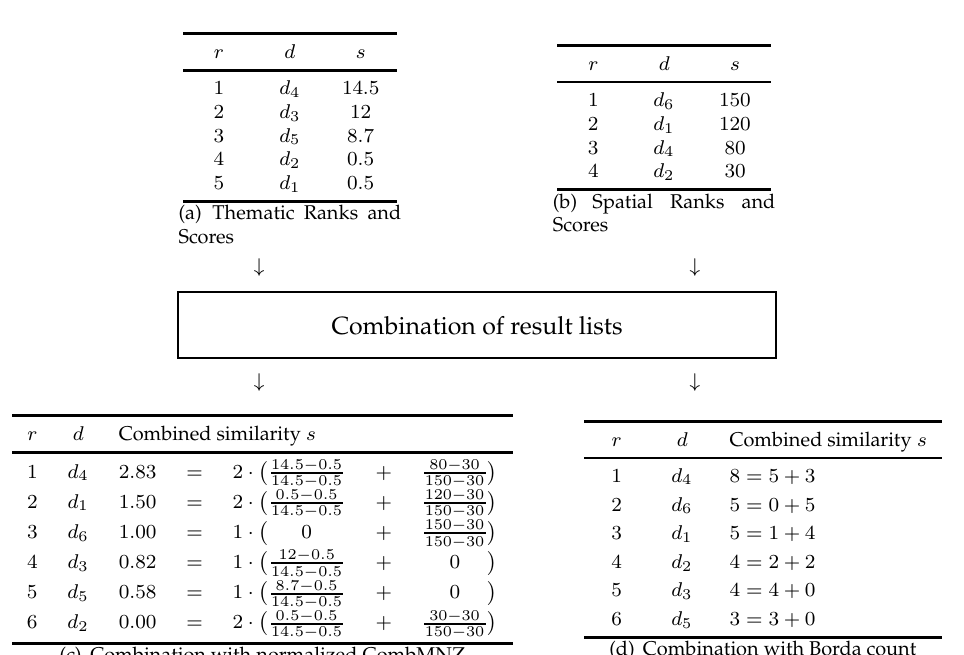
Figure 1: Illustration of result lists combination with (c) normalized CombMNZ versus (d) Borda count